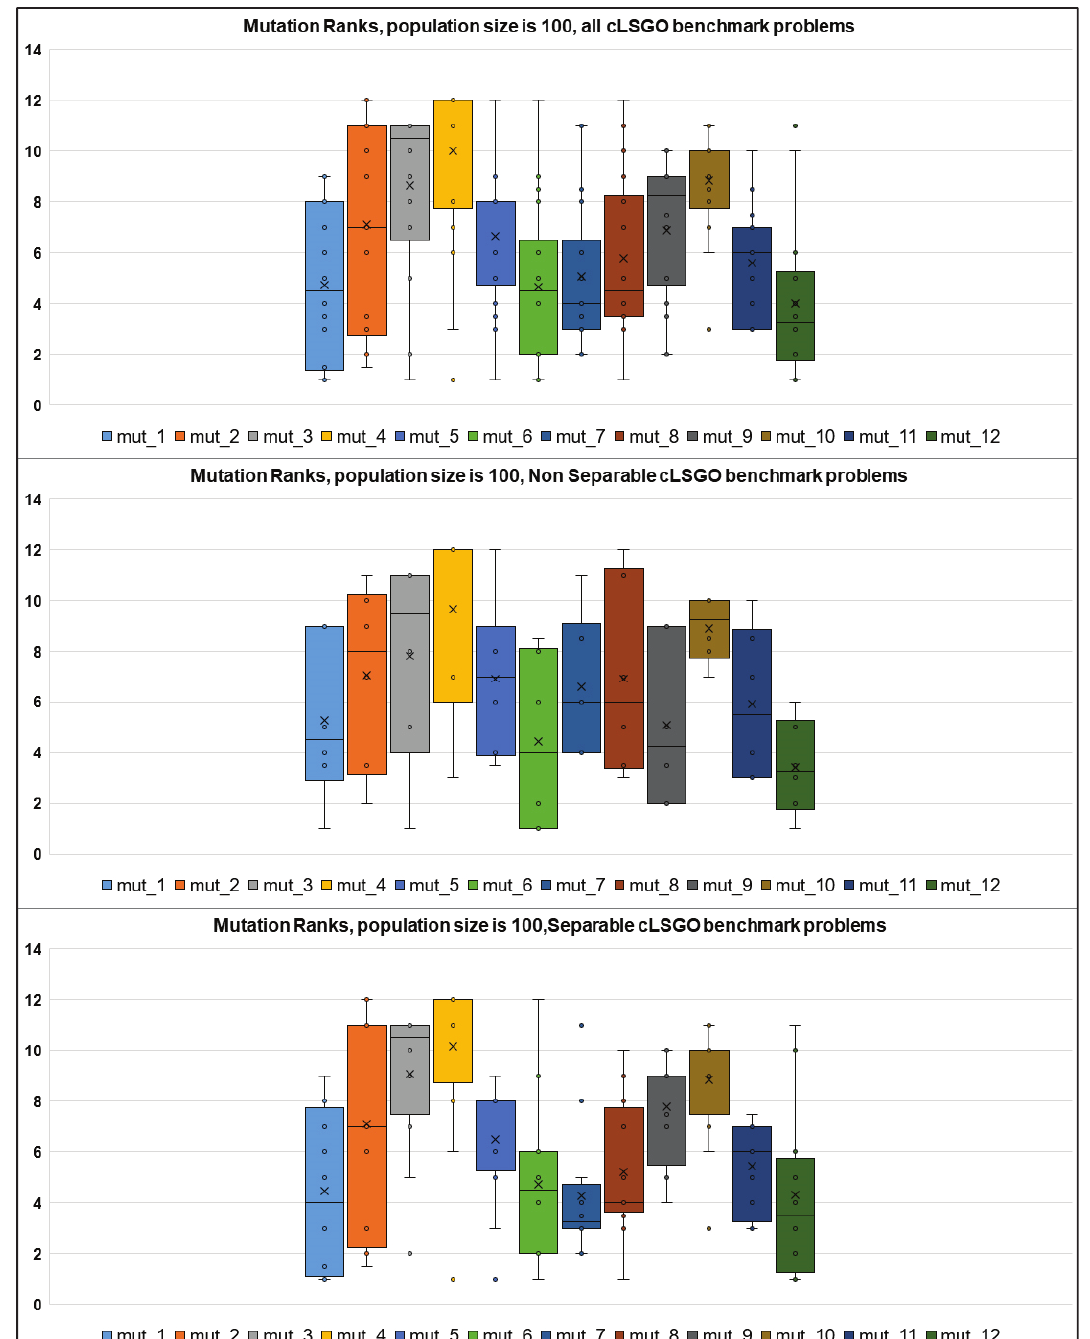
Figure 13. The ranking of different mutation strategies on the cLSGO benchmark problems.